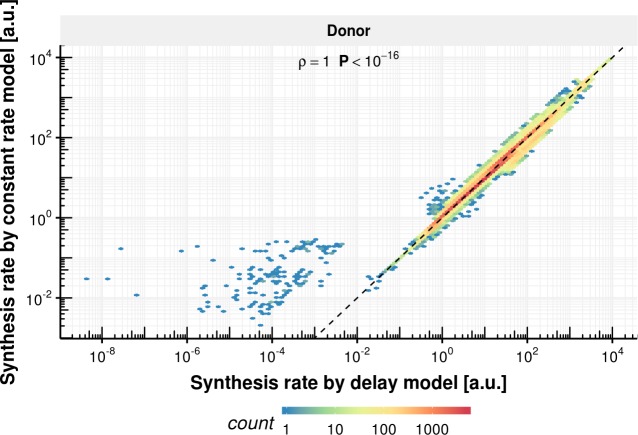
Synthesis rate comparison of delay and constant rate model.Synthesis rate estimated with the constant splicing rate model (y-axis) vs. synthesis rate estimated with the delay model (x-axis) for the donor bond based on the observed experimental data.